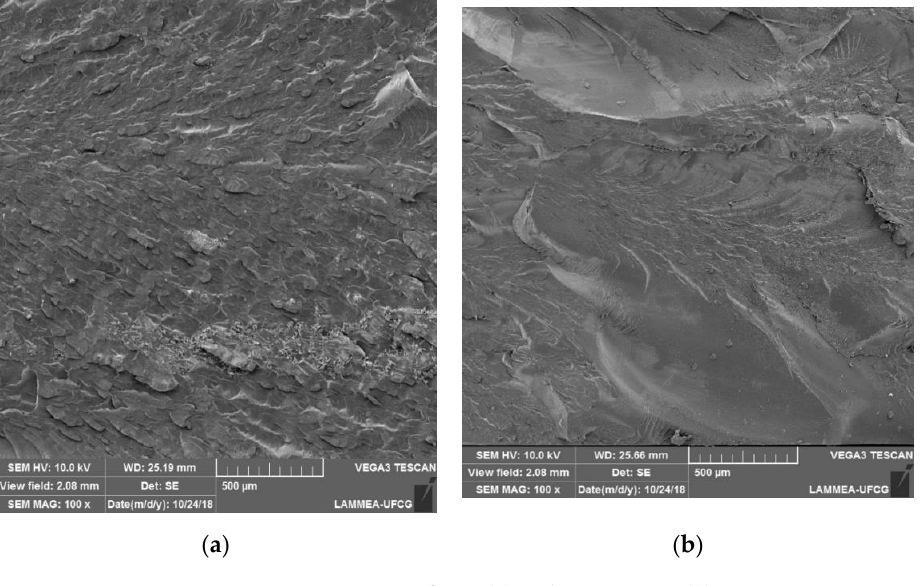
Figure 8. SEM images of PET ( a ) and PET–NaOH ( b ).